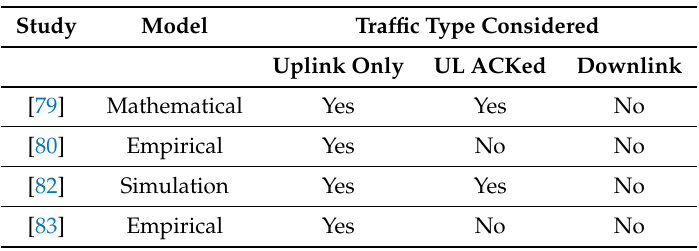
Table 6. Power consumption modeling for